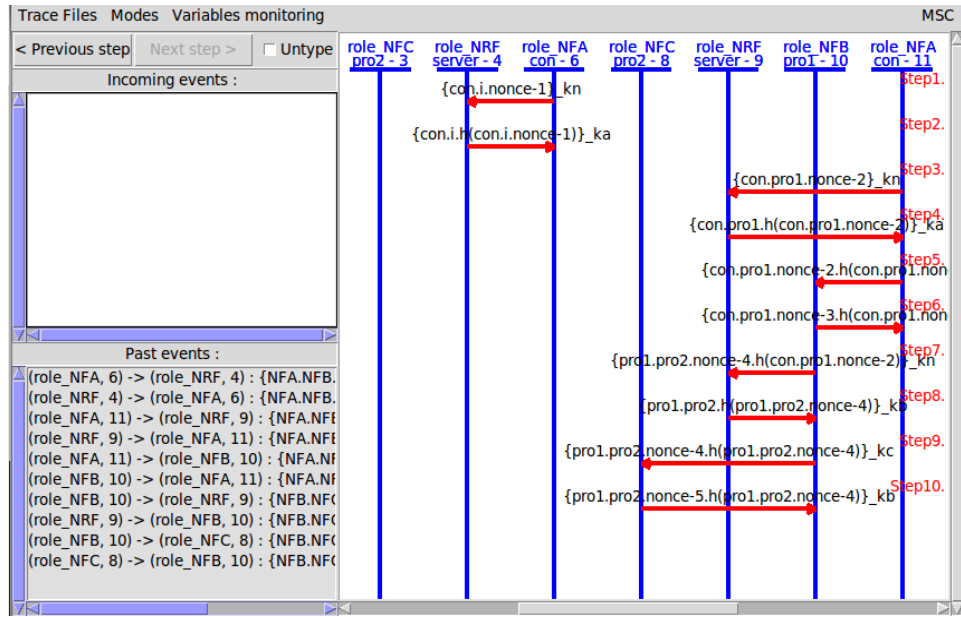
Figure 11. The MSC of the advanced protocol procedure.